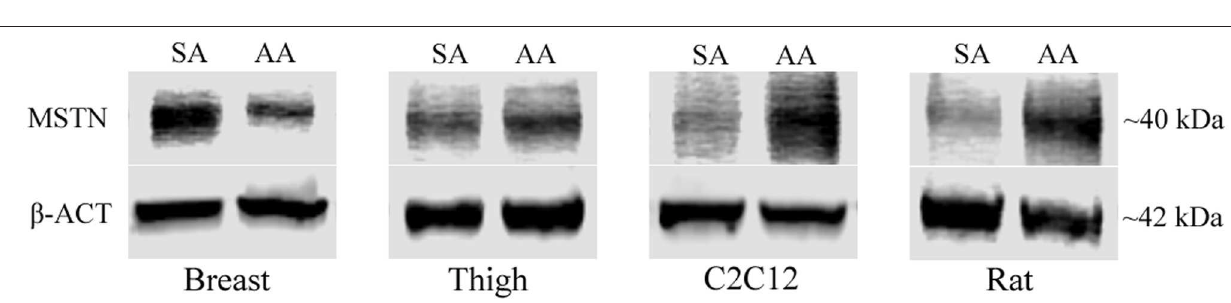
micropictograph images (40 × ) of each cell type and treatment are displayed in Figure 5